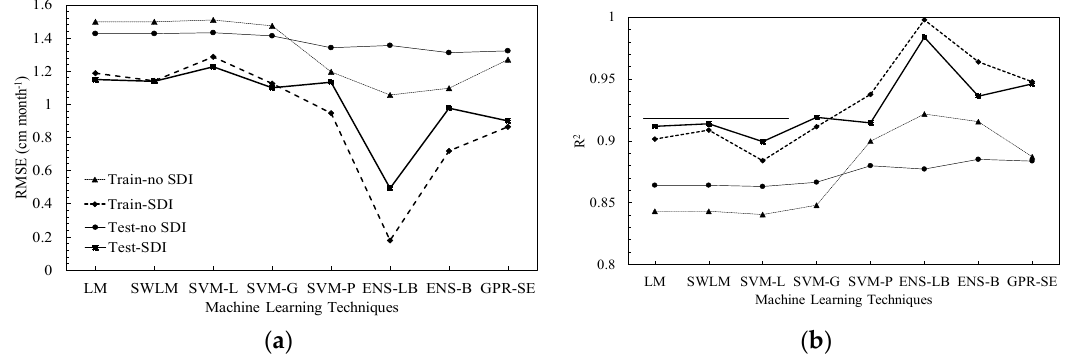
Figure 7. Performance of proposed models including RMSE ( a ) and R 2 ( b ) for prediction of bare soil drainage. (LM: linear model, SLM: stepwise linear mode, SVM-L, G & P: support vector machine with linear, Gaussian and polynomial kernel function, ENS-L&B: ensemble with LS boosting and Bagging algorithms, GPR-SE: Gaussian process regression with squared exponential kernel function).